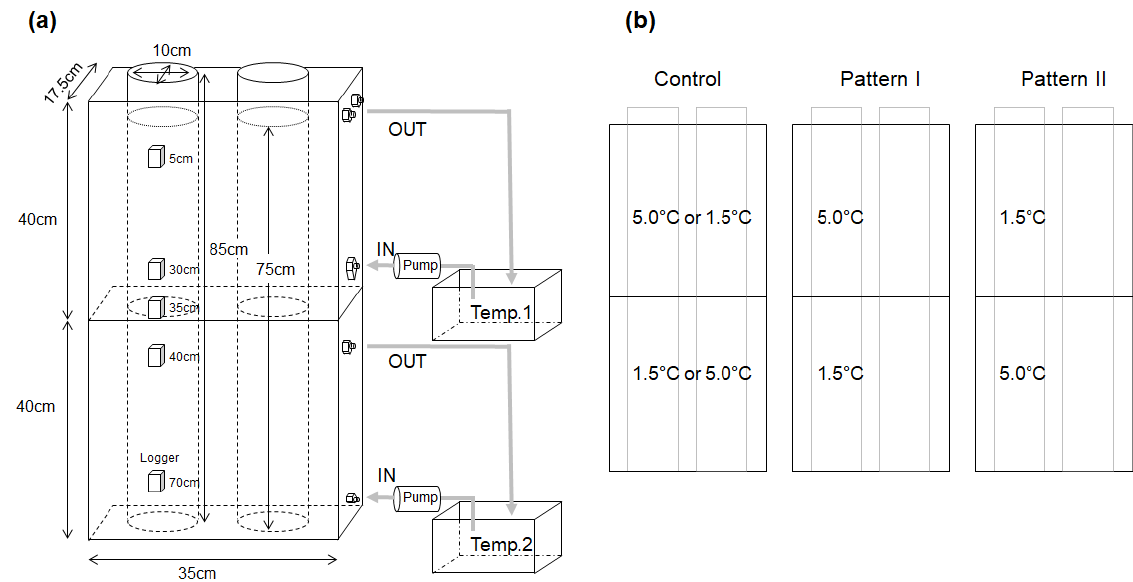
Figure 1. General design of the experimental tank system (Reprinted by permission from Springer Nature: Fisheries Science, Laboratory observations on the vertical swimming behavior of Japanese common squid Todarodes pacificus paralarvae as they ascend into warm surface waters, Yoo et al., copyright. 2014. [15]). ( a ) The two cylindrical tanks were each surrounded by an upper and lower water bath. ( b ) Three vertical patterns.